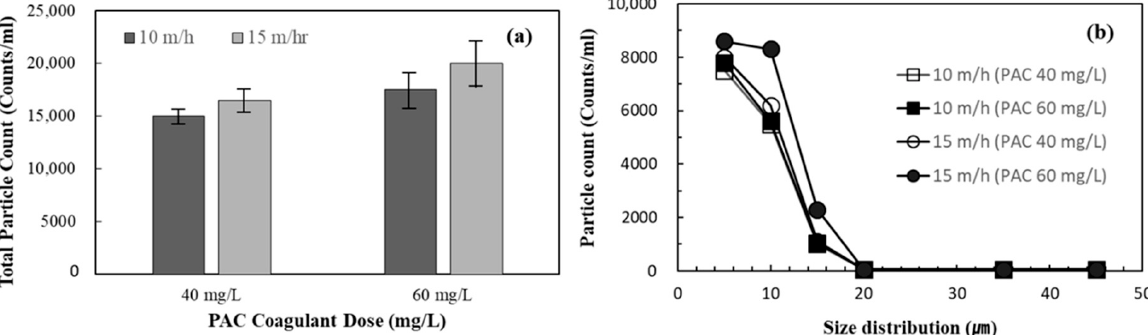
Figure 7. Particle count analysis according to coagulant does and hydraulic loading rate: ( a ) total particle count and ( b ) particle size distribution.